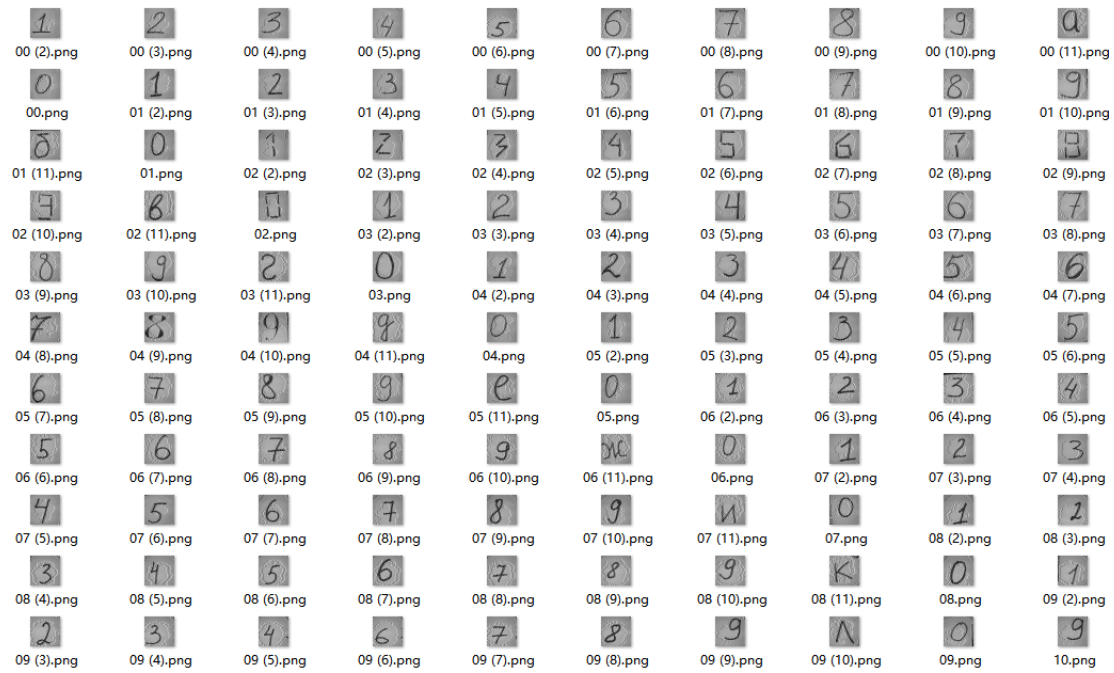
Figure 17. Experimental pictures of the